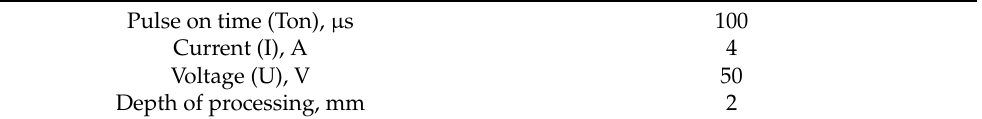
Table 1. Processing mode.